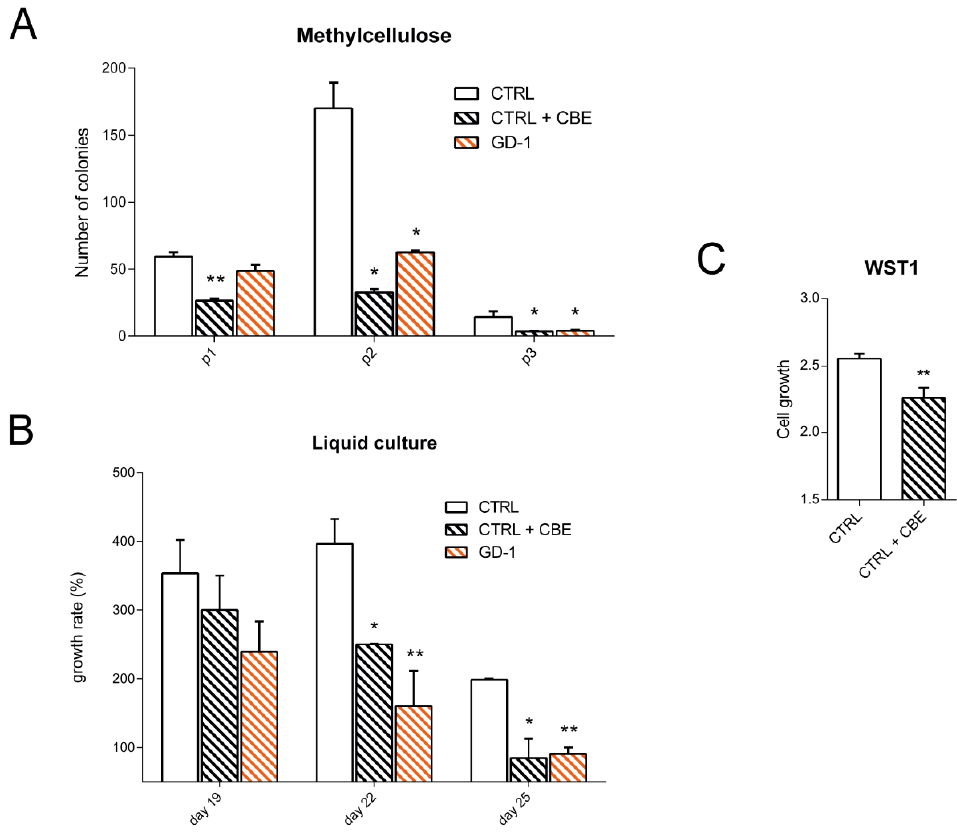
positive cells. n = 3. ( C ) Mature iPSC-derived monocyte/macrophage cells positivity for CD11b, CD14 and CD163 markers at day 19 of the differentiation protocol. The graph shows mean values and SEM of the percentage of positive cells. n = 3. * p < 0.05.